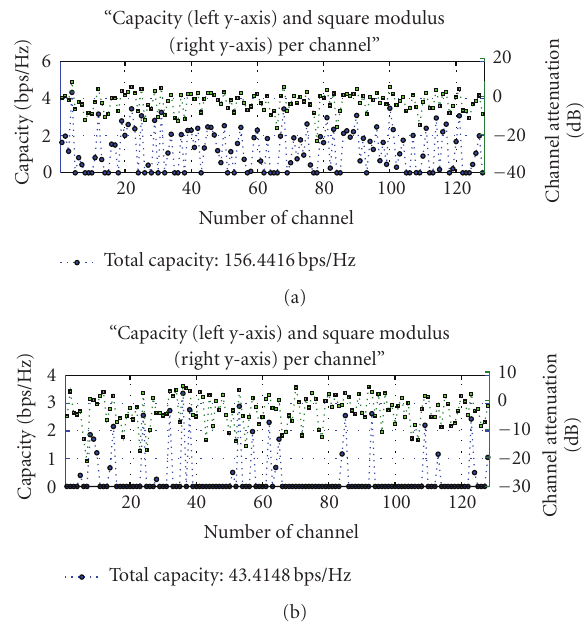
Figure 3: Attenuation and capacity per subchannel (primary/ secondary user), for the channel realization number 10,000 with SNR = 24dB.